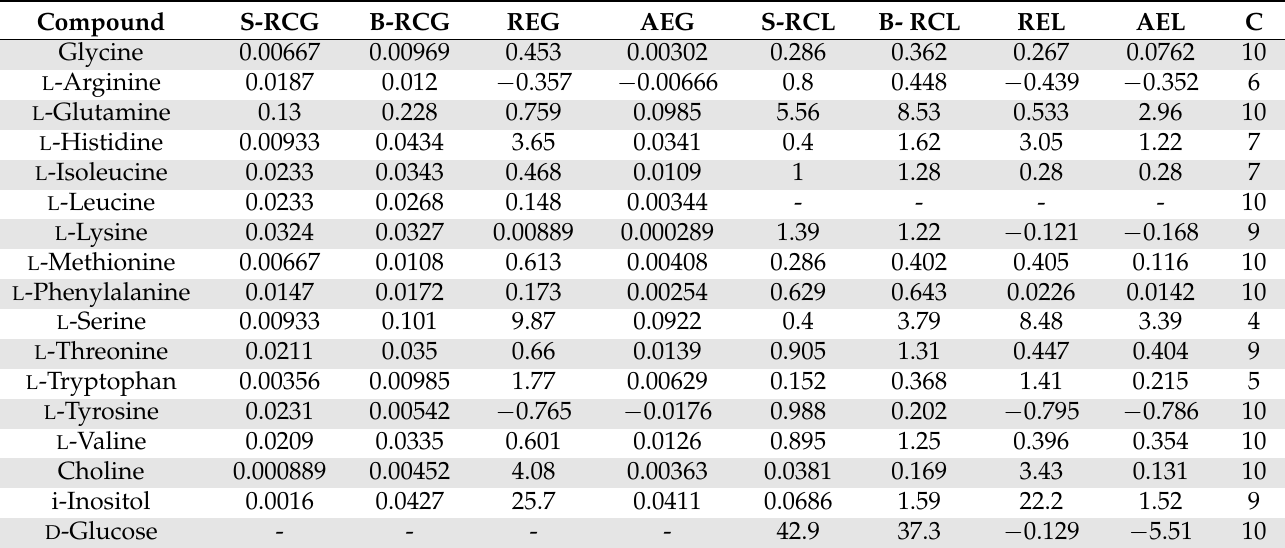
Table 3. Estimated relative concentration of metabolite from Bayesil. Prefix S- stands for the DMEM product specification, prefix B- stands for Bayesil, and RCG stands for relative concentration compared to D -Glucose. REG is the relative error for RCG, and AEG is the additive error for RCG. The heading RCL, REL, and AEL are similarly defined for concentration relative to L -Leucine. C stands for confidence score: higher is more confident. It ranges between 1 to 10, with 10 being most confidence. All numeric values are rounded to three significant